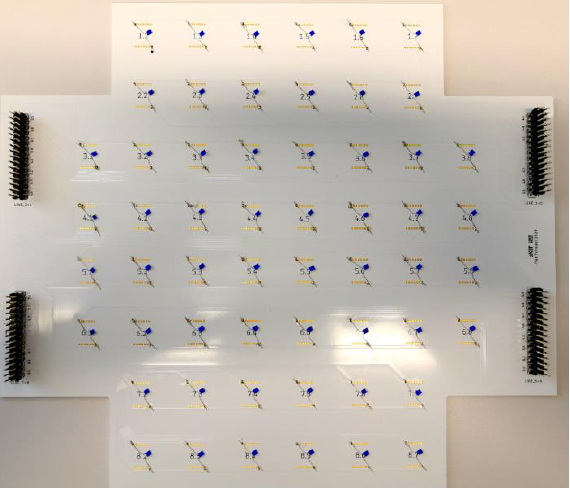
Figure 12. Metal core PCB with 56 soldered Pt1000 temperature sensors (blue). On the left and right, pin headers were placed to easily connect the sensors to the measurement electronics by ribbon cables.